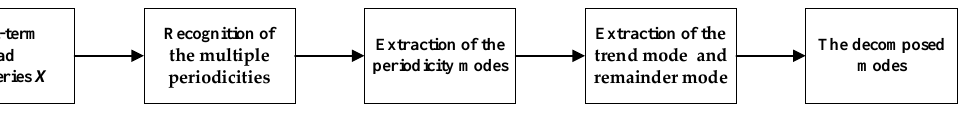
Figure 3. Flowchart of the proposed decomposition method.